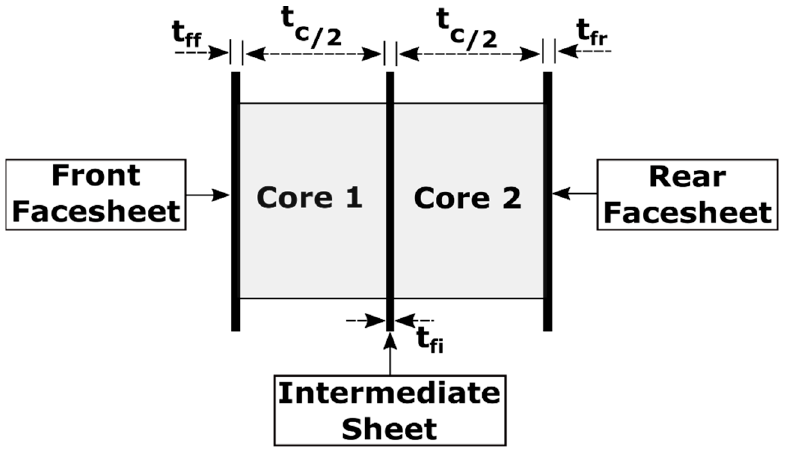
Figure 3. Double ‐ honeycomb (DHC) sandwich panel configuration. Figure 3. Double-honeycomb (DHC) sandwich panel